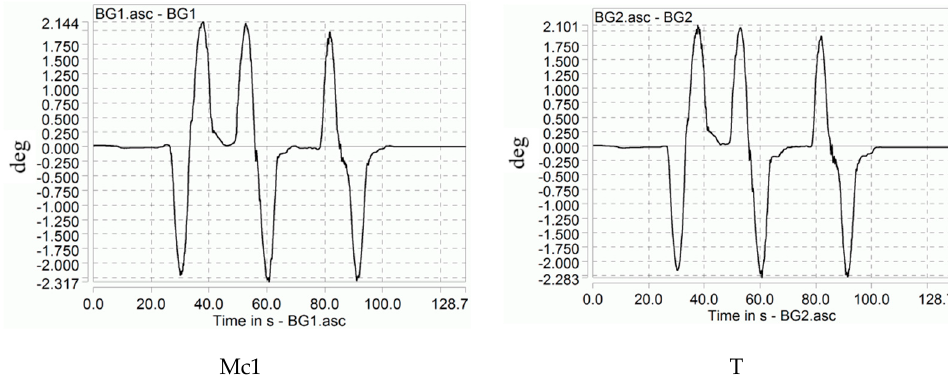
Figure 24. Mc1 and T relative to their own bogies on the S-shaped curve line.